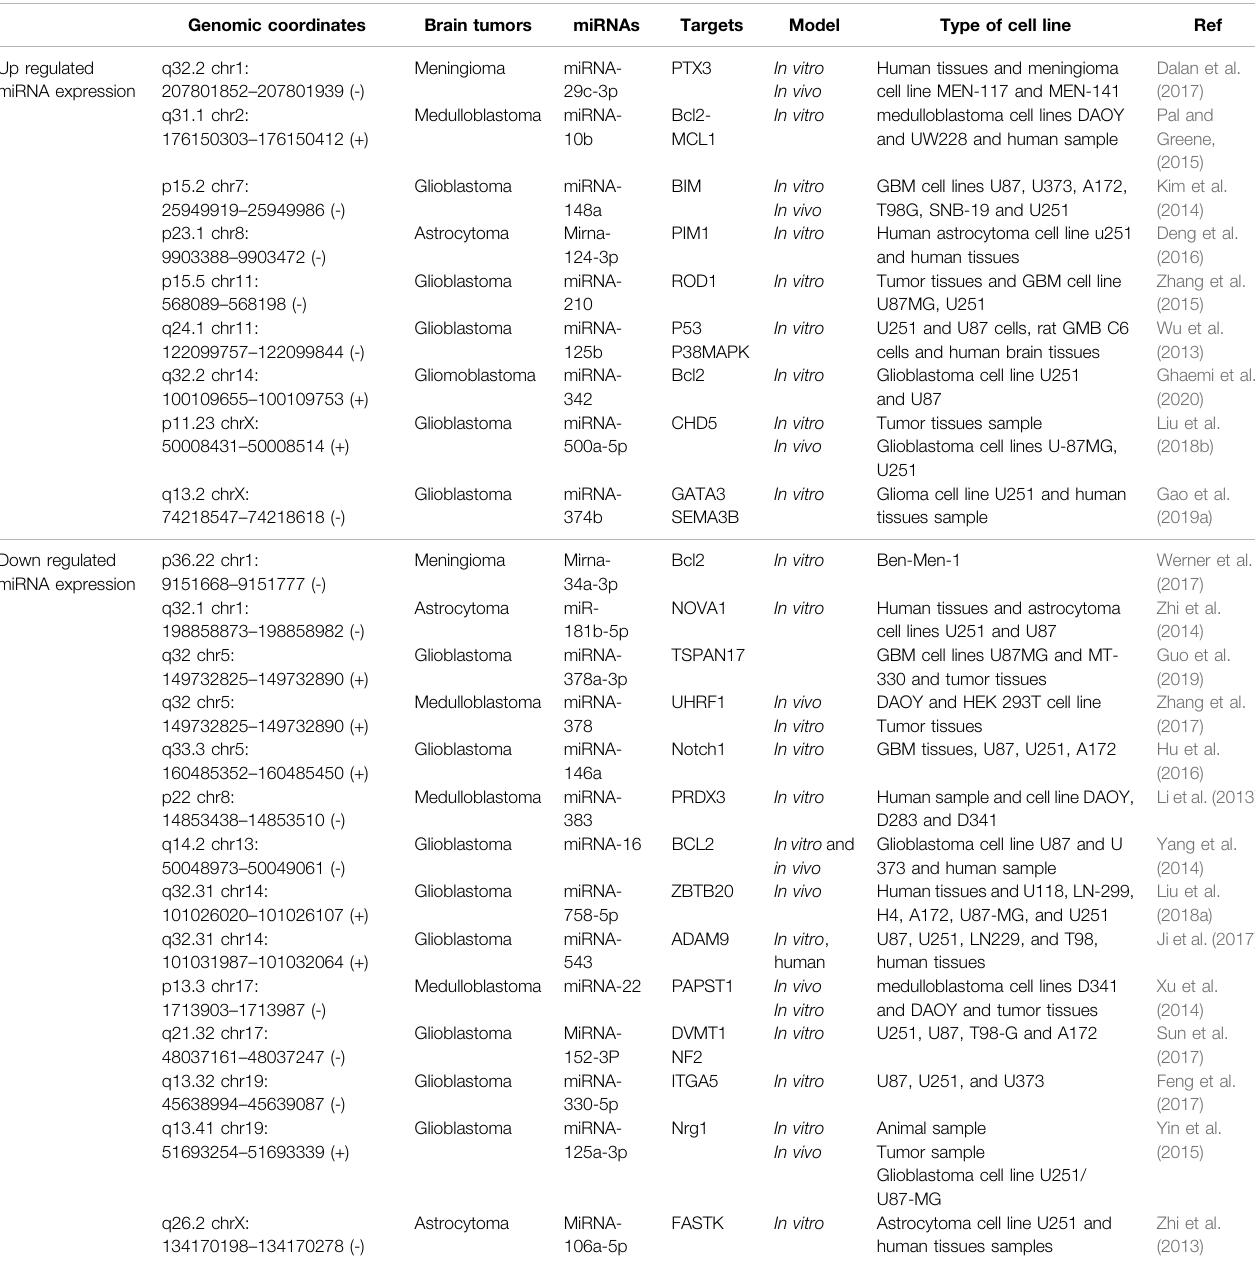
TABLE 1 | Apoptosis-related miRNAs in brain